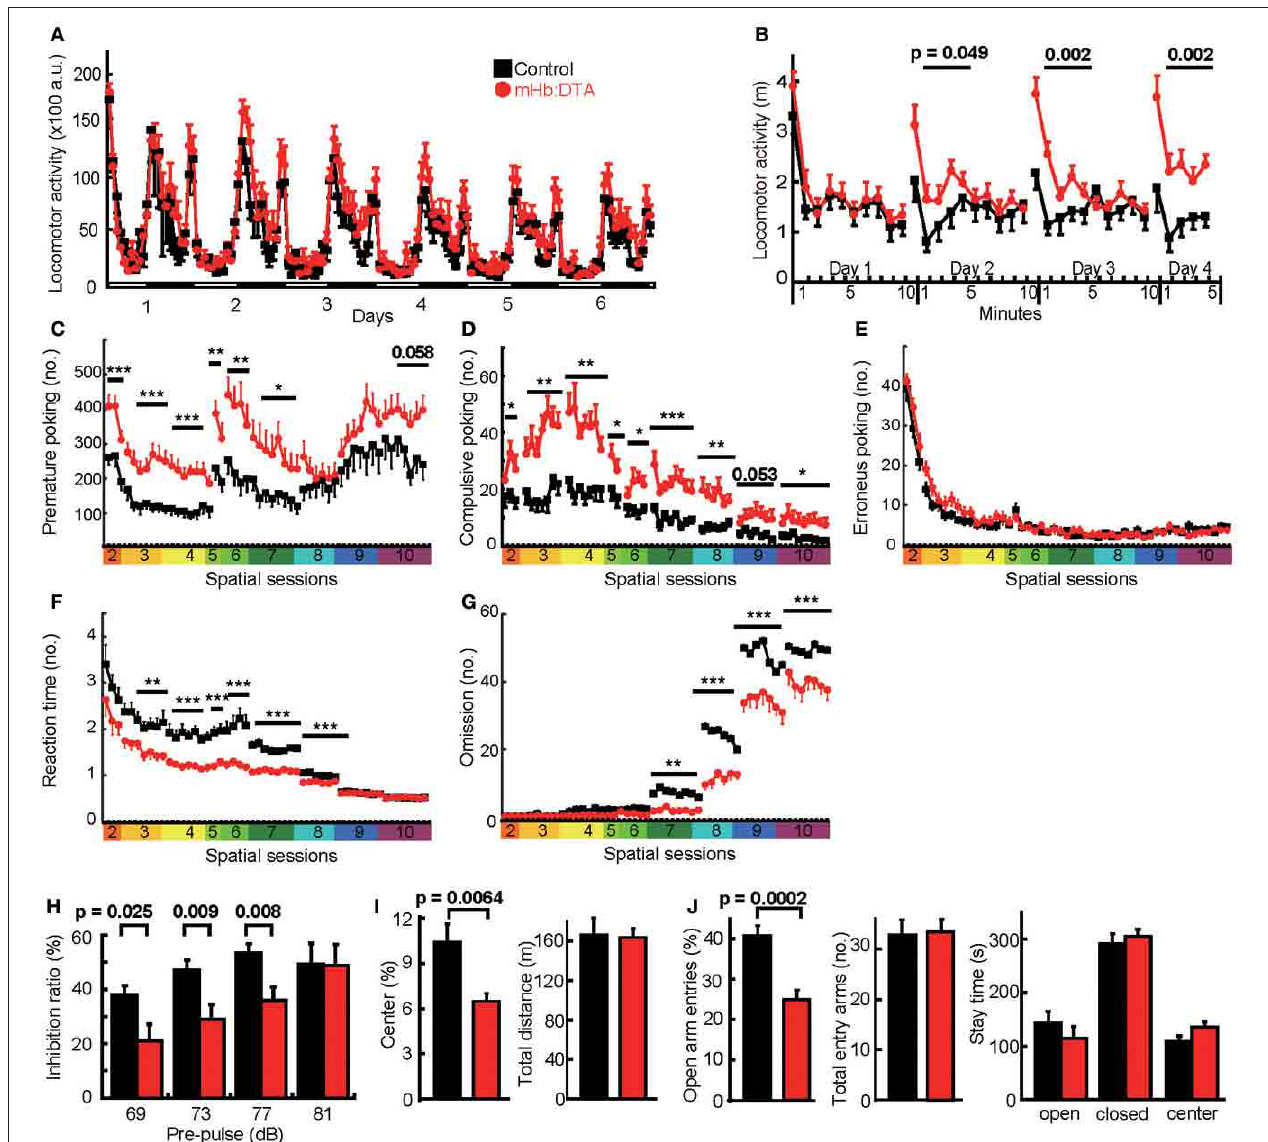
FIGURE 3 | Maladaptation and impulsive/compulsive behavior in mHb:DTA mice. (A) Locomotor activity of control (black) and mHb:DTA (red) mice in home cages (mice were 5–6 months old, n = 12/group). Levels of locomotor activity per hour. White and black bars represent light (day) and dark (night), respectively. (B) mHb:DTA mice failed to show habituation during repeated exposure to a new environment [mice were 7–8 months old, n = 12/group; for days 1, 2, 3, and 4; genotype, F ( 1 , 22 ) = 0 . 47, 4.36, 12.5, and 12.3, respectively; genotype × time, F ( 1 , 22 ) = 0 . 90, 1.15, 3.95, and 1.49, P = 0 . 46, 0.33, 0.0053, and 0.21, respectively]. ( C–G) 5-CSRTT (mice were 6–8 months old, n = 12/group). (C) Total number of premature nose-pokes was significantly higher in mHb:DTA mice [spatial sessions 2, 3, 4, 5, 6, and 7: F ( 1 , 22 ) = 17 . 2, 14.6, 16.9, 8.16, 8.85, and 5.30, respectively, genotype × day interaction, P > 0 . 05 for all sessions]. (D) Compulsive nose-pokes after success was increased in mHb:DTA mice [spatial sessions 2–10: genotype effect, F ( 1 , 22 ) = 4 . 90, 12.9, 18.8, 4.68, 6.65, 15.6, 10.1, and 6.47, respectively, genotype × day interaction, P > 0 . 05 for all sessions]. (E) The number of erroneous nose-pokes was comparable between mHb:DTA mice and control mice. (F) Latency to poke the correct hole